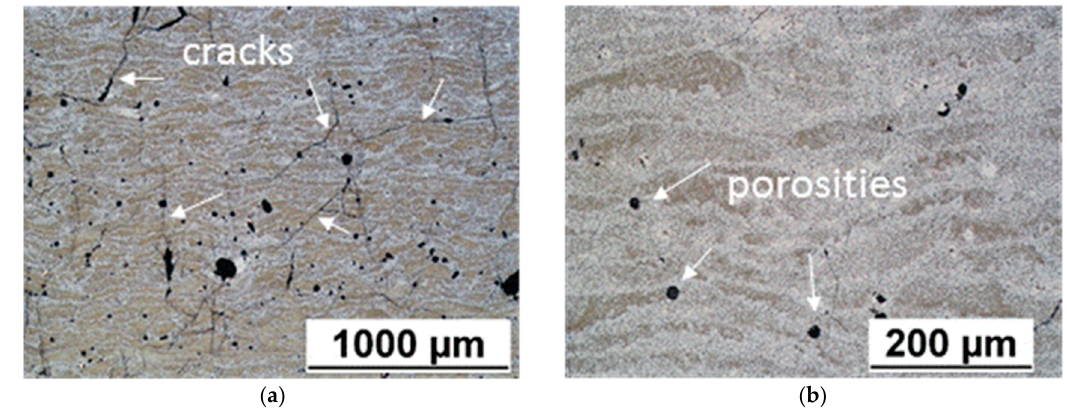
Figure 3. Micrographs revealing ( a ) cracks and ( b ) porosities of a specimen cross section.